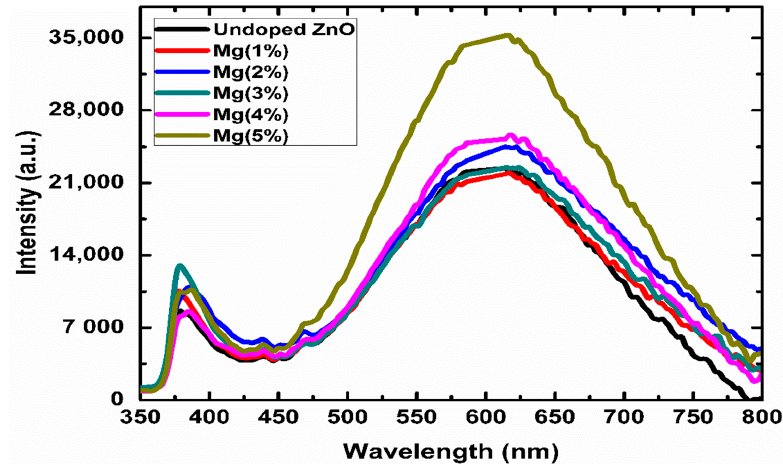
Figure 3. PL patterns of the ZnO and Mg-doped ZnO nanorods at room temperature at different molar ratios.